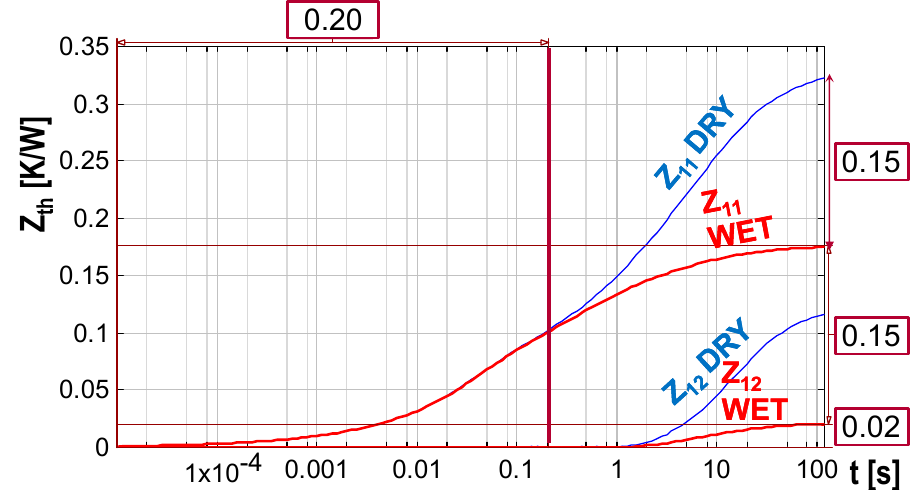
Figure 25. Self- and transfer-heating Z th in the IGBT module (“dry” curves are thin, blue lines, “wet” curves are thick, red lines).